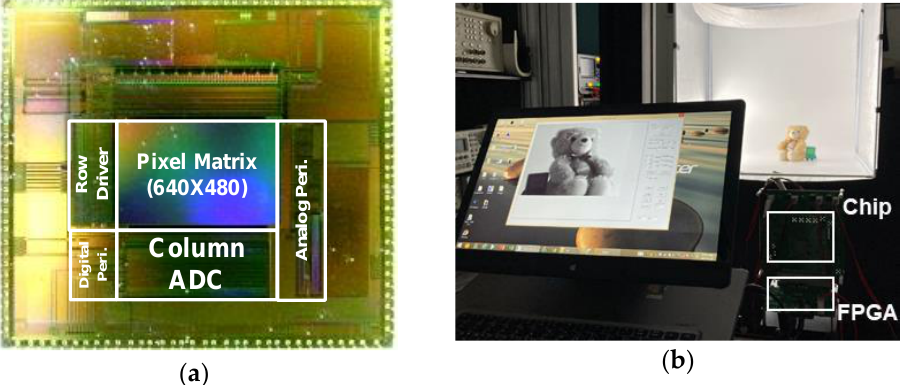
Figure 6. ( a ) Chip microphotograph and ( b ) test environment.